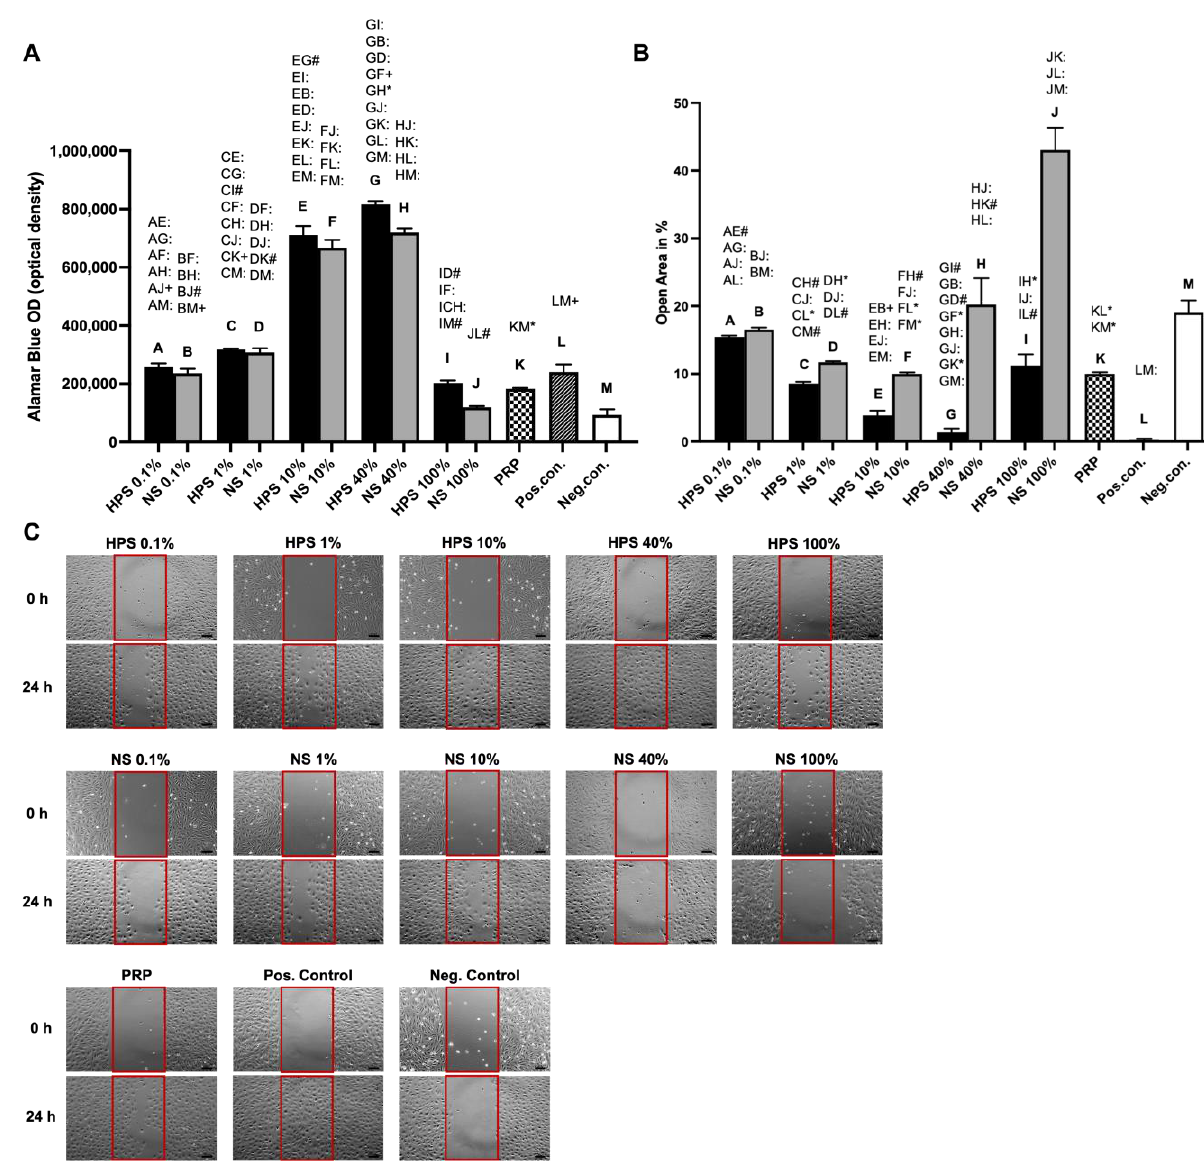
Figure 2. The effect of HPS, NS, and PRP on proliferation and migration of LECs. LECs were stimulated by HPS/NS-0.1%, -1%, -10%, -40%, 100%, and PRP (pooled from ten donors) compared to positive/negative control. ( A ) Plot showing Alamar Blue proliferation assay measured in optical density (OD) after 96 h of stimulation. ( B ) Plot showing closure of the open area (residual area in % of the full area) after 24 h calculated by image analysis of the digital photographs depicted in ( C ). ( A , B ): One-way repeated- measures ANOVA with Tukey’s multiple comparison test. Data points are means ± SEM, LEC donors: n = 3. Capital letter pairs over plots indicate statistical comparison of corresponding data points. For all pair comparisons, * = p < 0.05, # = p < 0.01, + = p < 0.001, : = p < 0.0001. ( C ) Representative microscopic photographs of scratch assay of LECs ( n = 3) stimulated by the blood-derived secretomes, taken at 0 h and 24 h. Red boxes indicate the initially standardized open area. Scale bar = 100 μm.